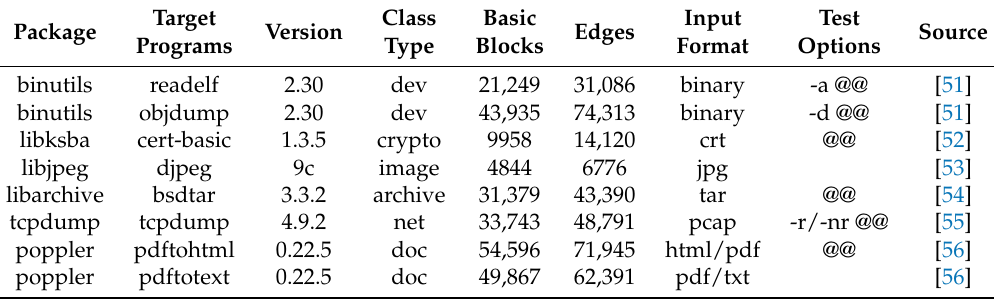
Table 4. Statistics on the eight evaluated real-world software applications.